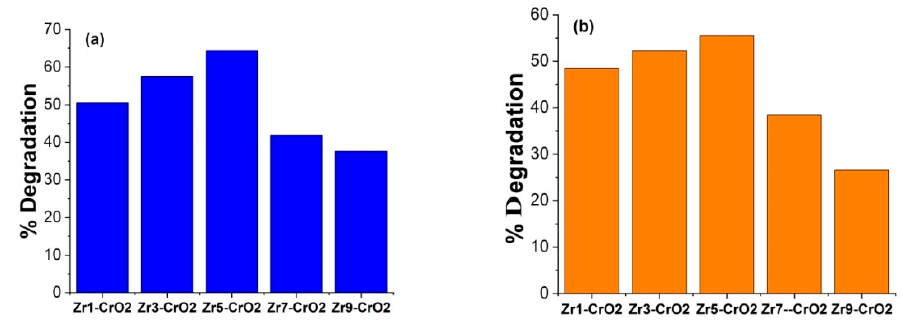
Figure 11. ( a ) Methylene blue ( b ) Methyl orange percent degradation at 140 min.